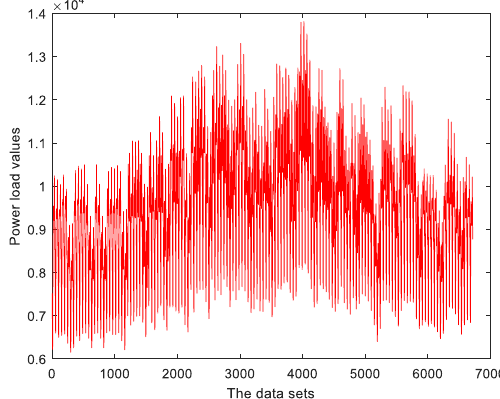
Figure 8. The electricity load dataset.